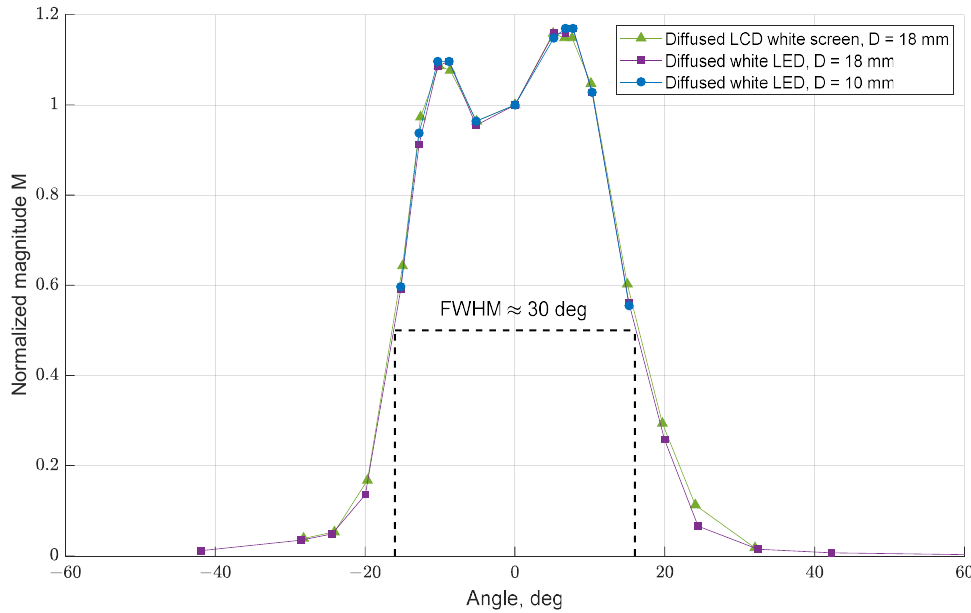
Figure 6. Normalized angular response curve for different illumination conditions (tests 1, 2, and 3, SQM-LE 5009).